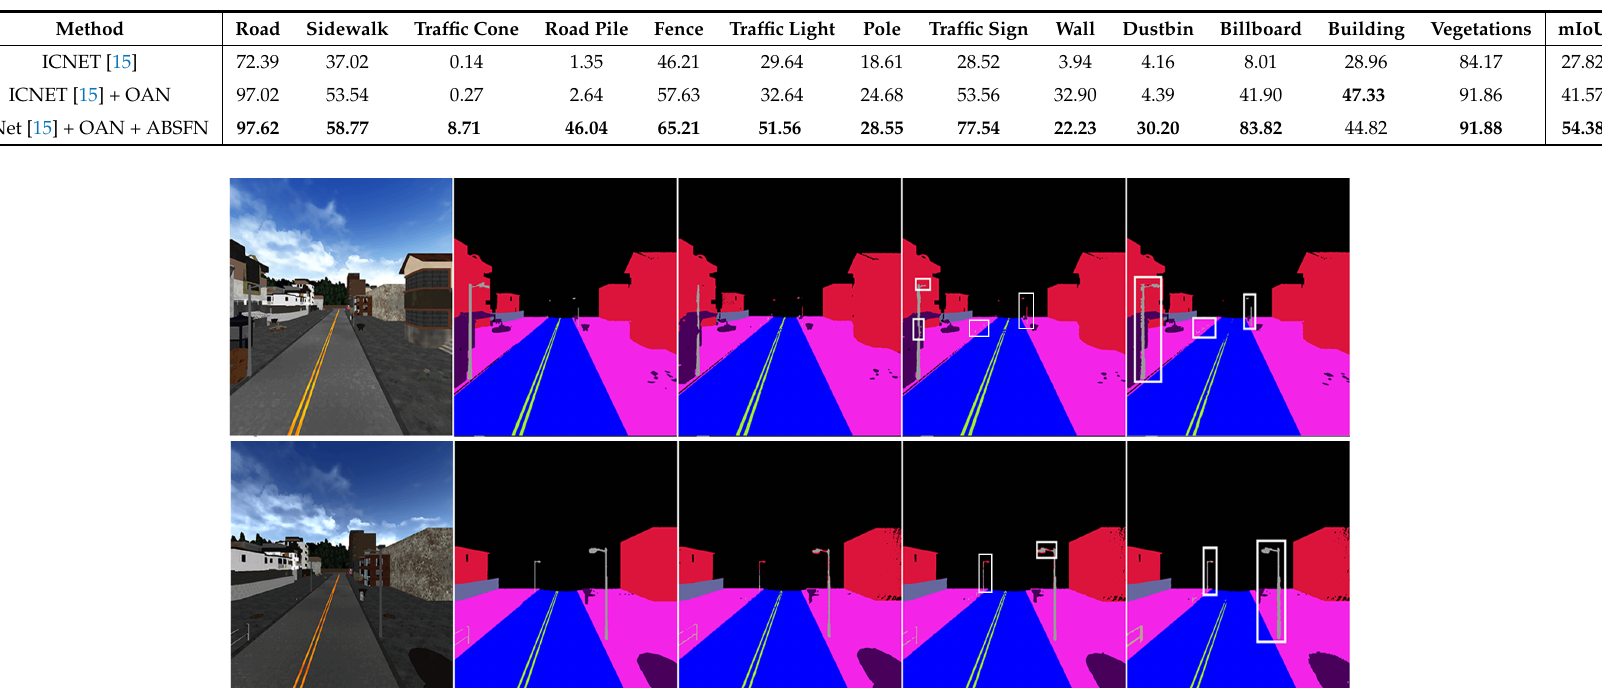
Table 2. Comparison on Apollo dataset. The bold fonts indicate the best results.